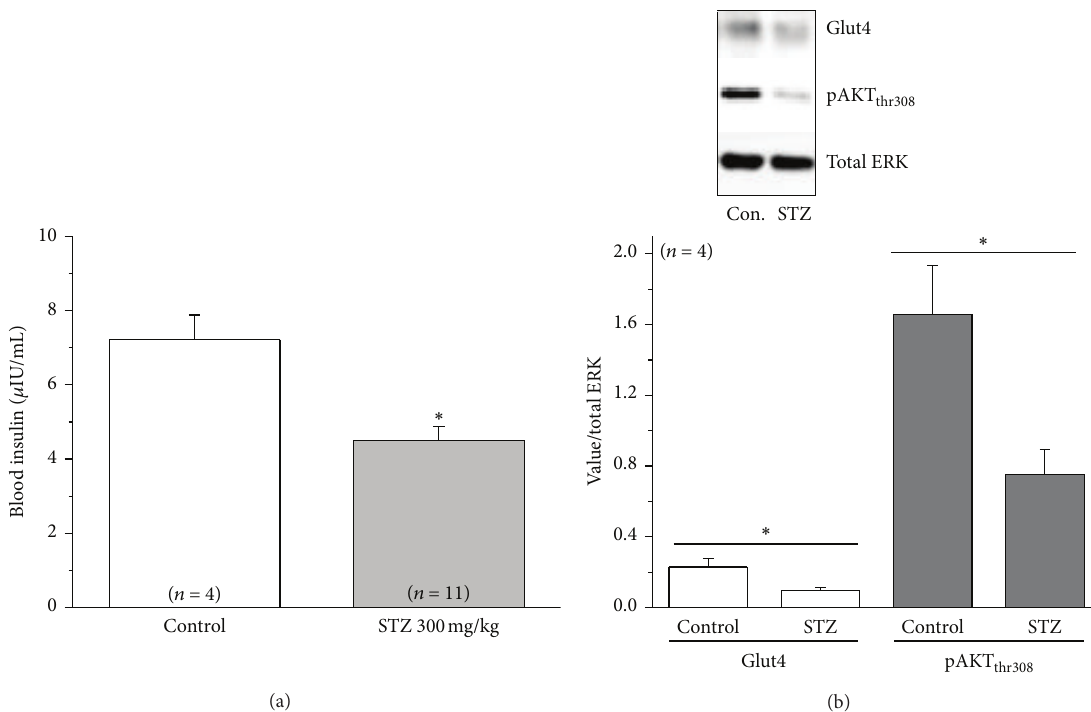
Figure 3: STZ-injected embryos display changes in biomarkers that are characteristic to diabetes. (a) Blood insulin from STZ-injected embryos (E18) is significantly lower than the control (injected with vehicle). (b) The protein levels of glucose transporter 4 (Glut4) and ) are significantly lower in the STZ-induced diabetic retinas compared to the phosphorylated AKT at thr308 (pAKT thr 308